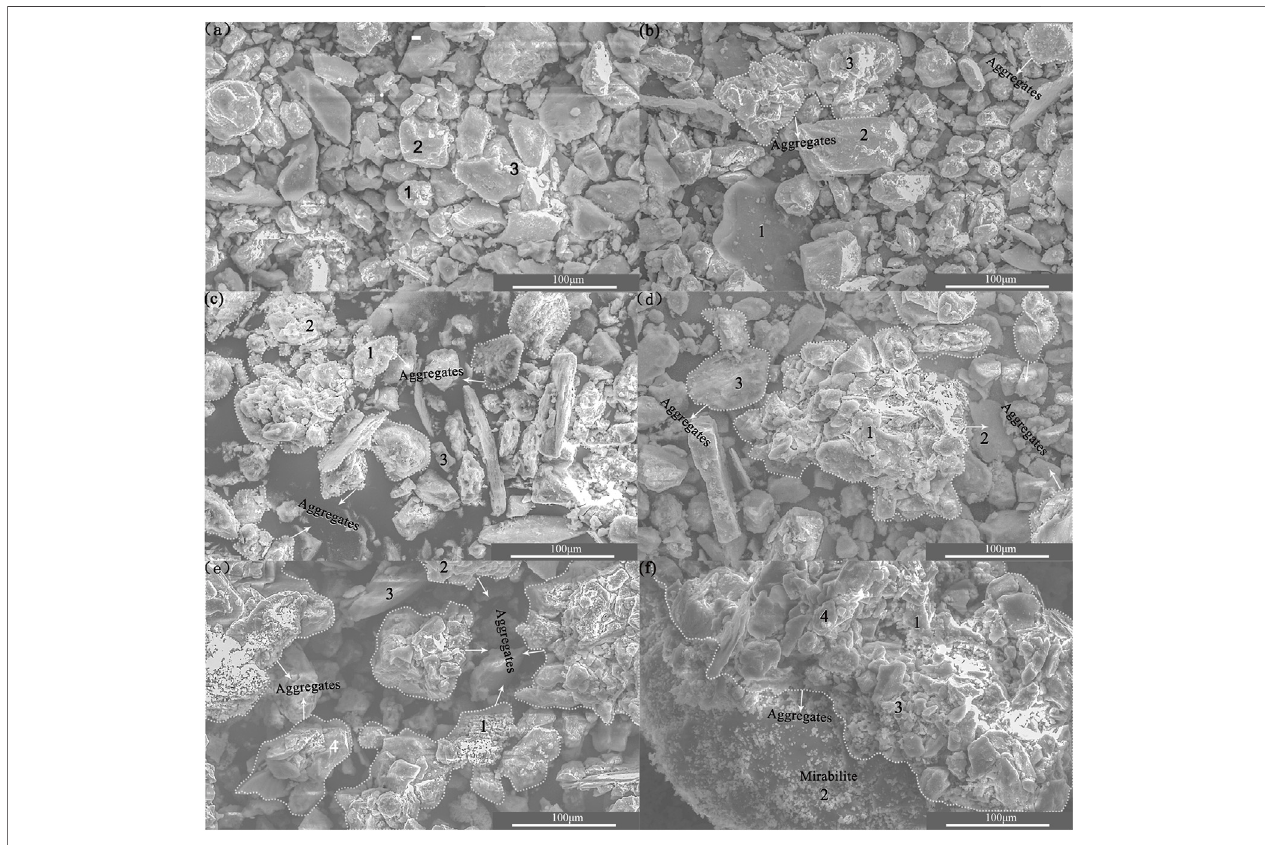
FIGURE3| SEMgraphofdifferentsulfatecontentinsalinesoil (A) :0%saltcontent, (B) :0.3%saltcontent, (C) :0.5%saltcontent, (D) :3.0%saltcontent, (E) :5.0% salt content, and (F) : 8.0% salt content.